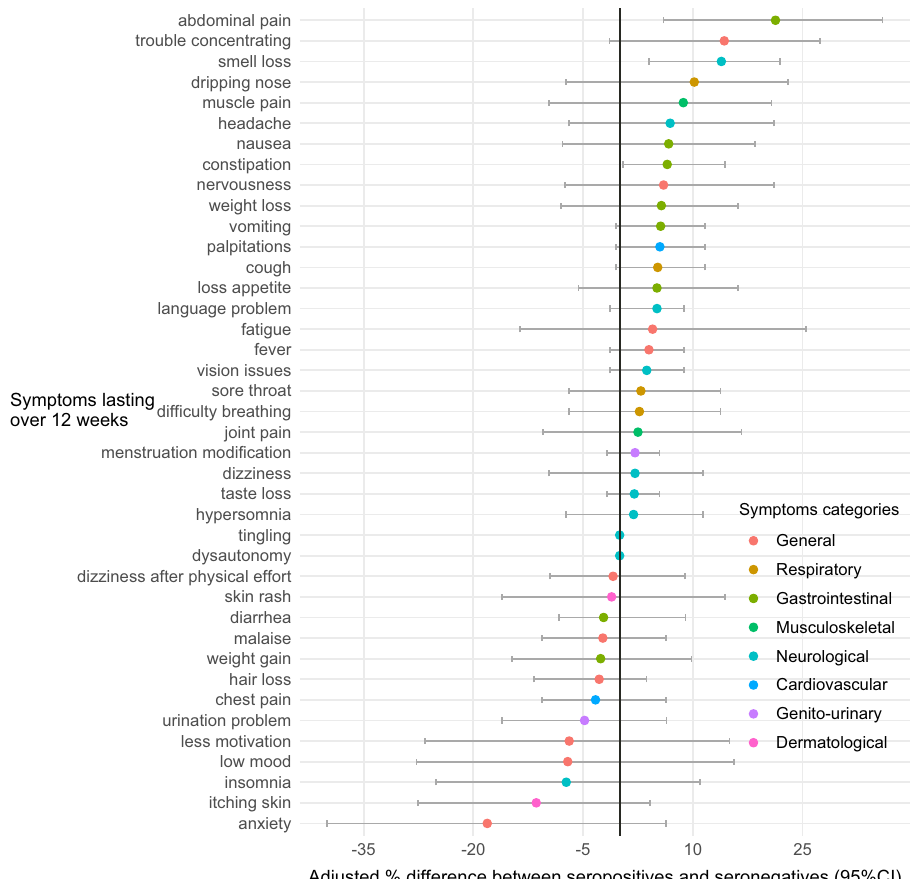
Fig.2|Sex-andage-adjusteddifference(%)ofsymptomslastingover12weeks between seropositive and seronegative children, December- February 2022, Geneva,Switzerland. Samplesize:79childrenandadolescentswhomexperienced symptoms lasting over 12week. The colored dots refer to types of symptoms, as